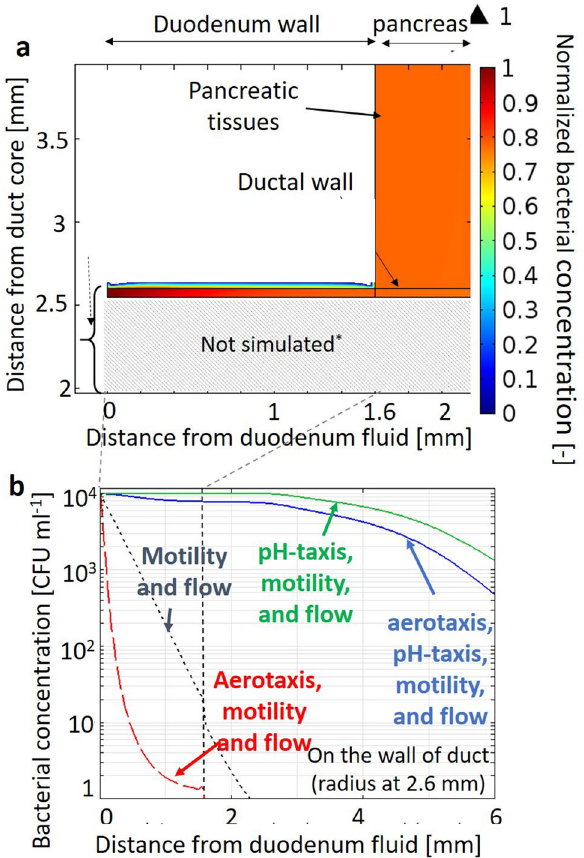
Figure 4. Simulated bacterial concentrations in hepato-pancreatic duct and surrounding pancreatic tissues in cancer patients ( a ) and those on the wall of the duct ( b ). The major driving force of bacterial migration is pH-taxis from acidic to neutral pH. This migration is made easier by reduced pancreatic juice and bile flow rate due to obstructions of the pancreatic and bile duct by solid